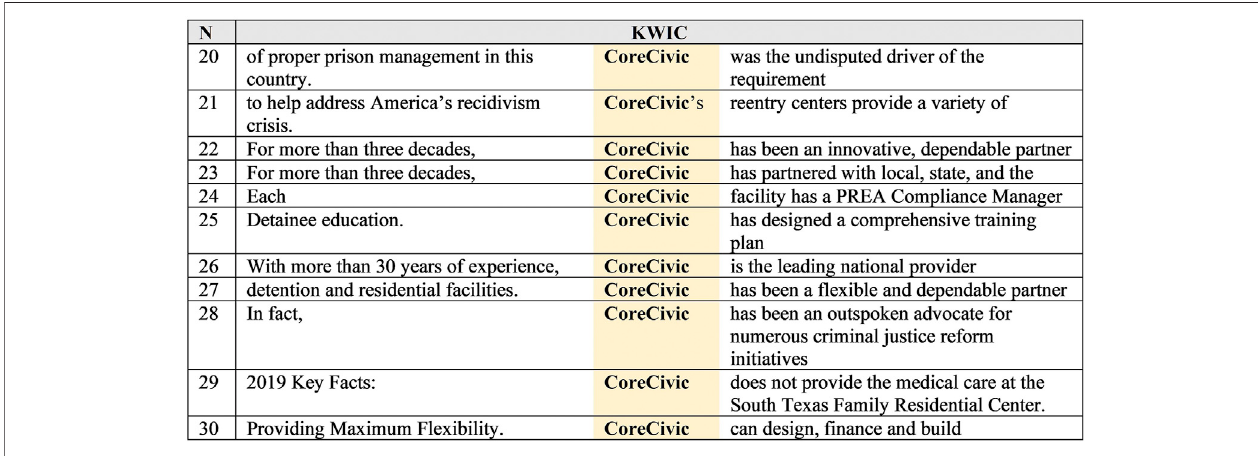
FIGURE 1 | CoreCivic corpus, “ CoreCivic ” concordance lines 20 – 30.